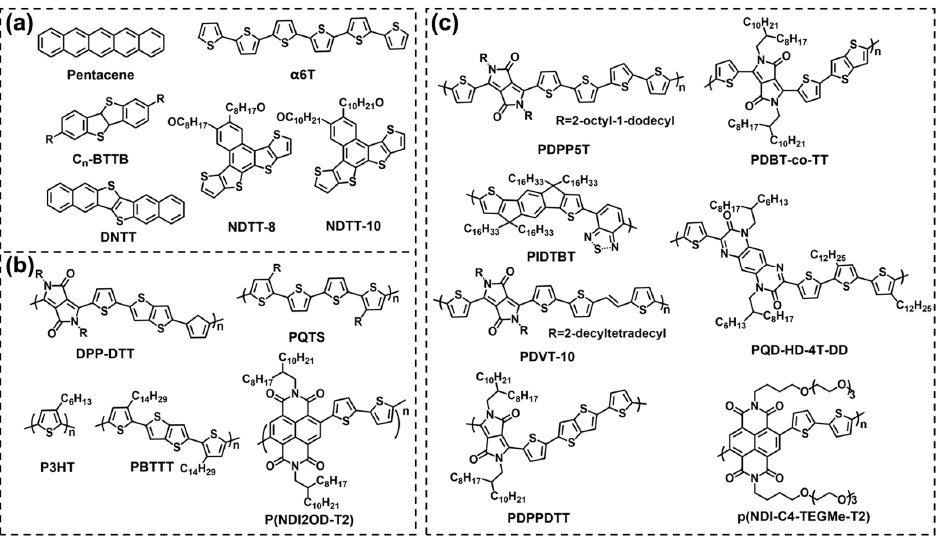
Figure 7. Chemical structures of organic small molecule semiconductors ( a ) and organic polymer semiconductors ( b , c ).